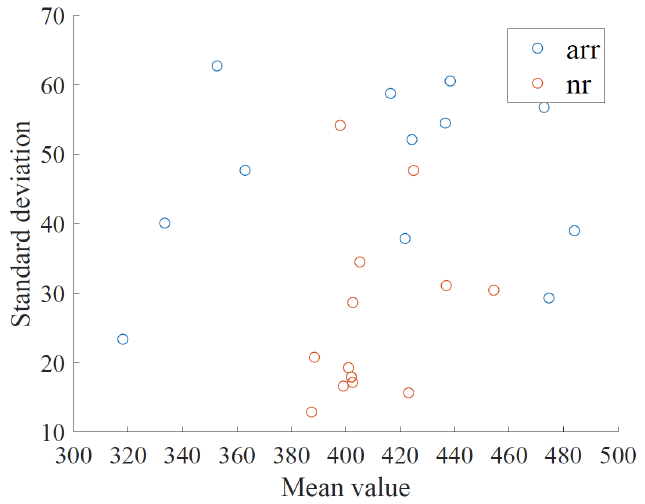
Figure 12. The scatter plot of the mean and standard deviation of the RRI for each of the